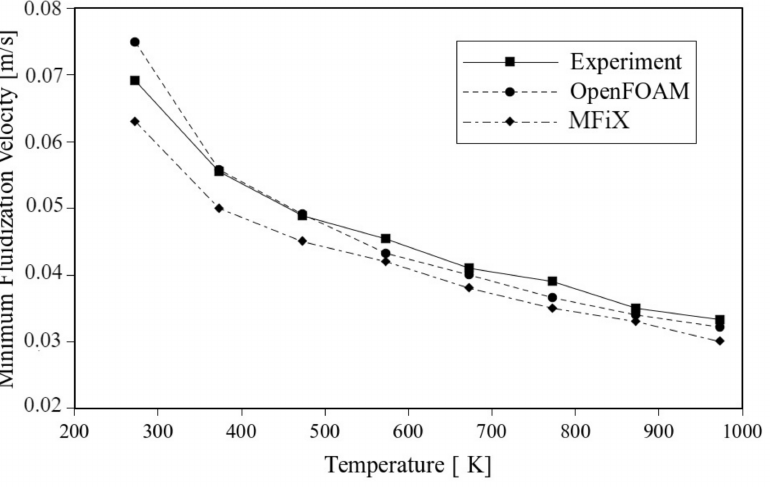
Figure 2. Minimum fluidization velocity as a function of the temperature of the bed based on experiments and